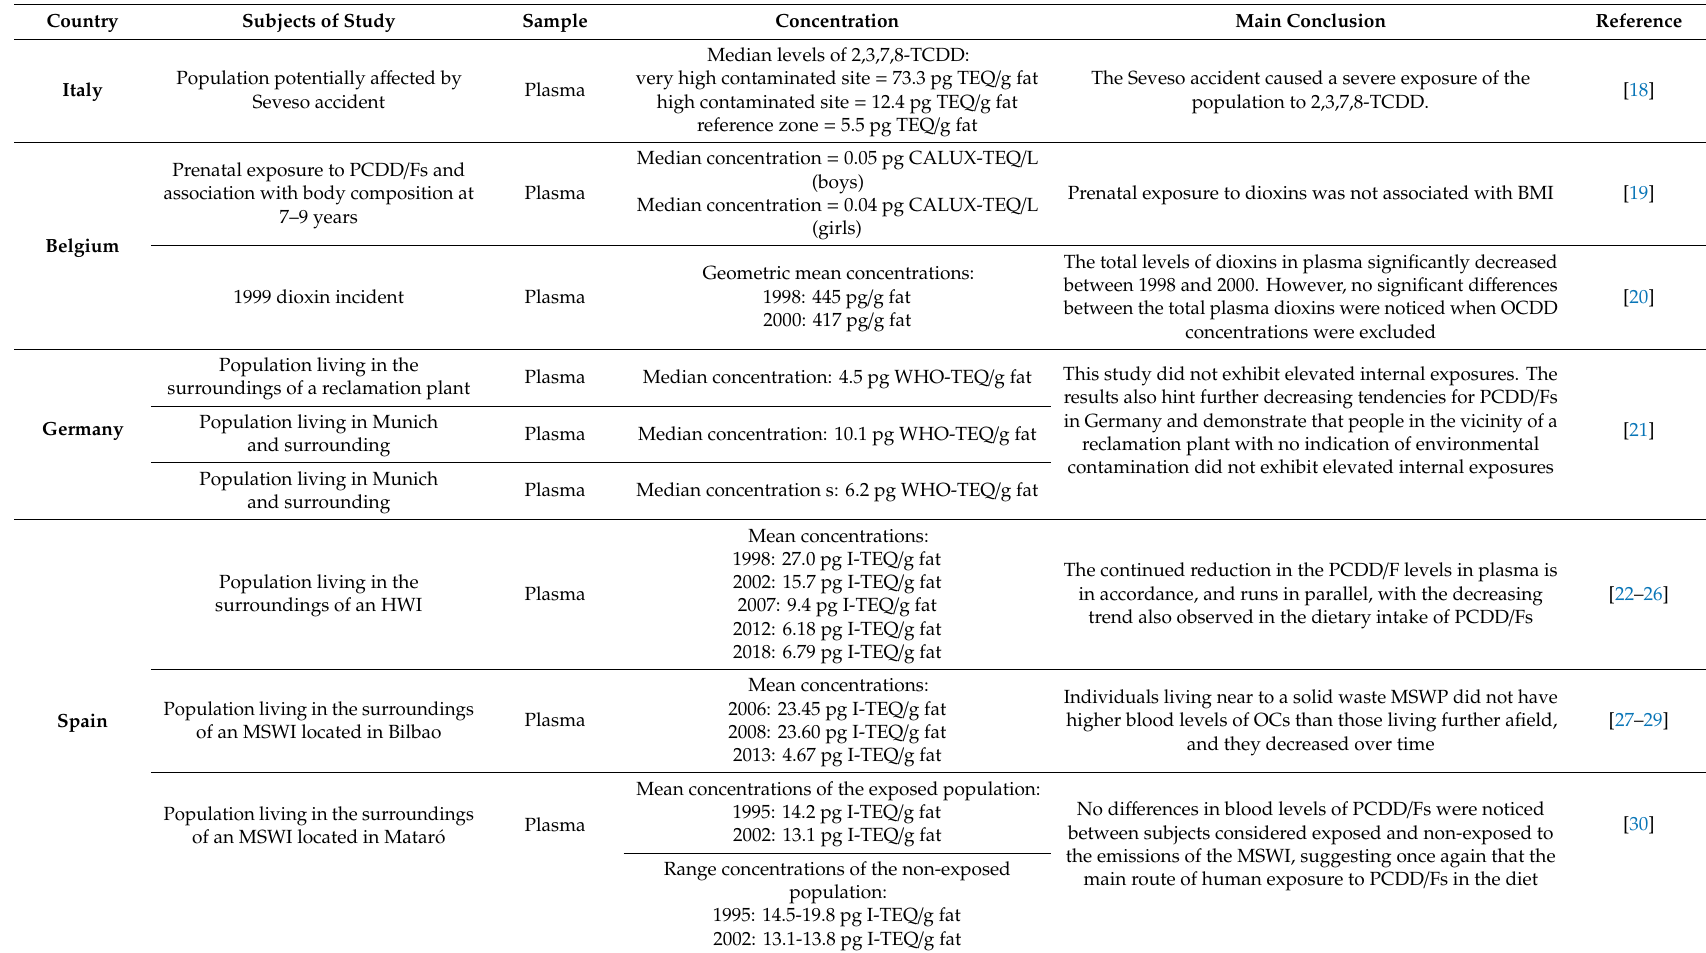
Table 1. Summary of the most relevant studies on the occurrence of PCDD / Fs in the blood of non-occupational exposed